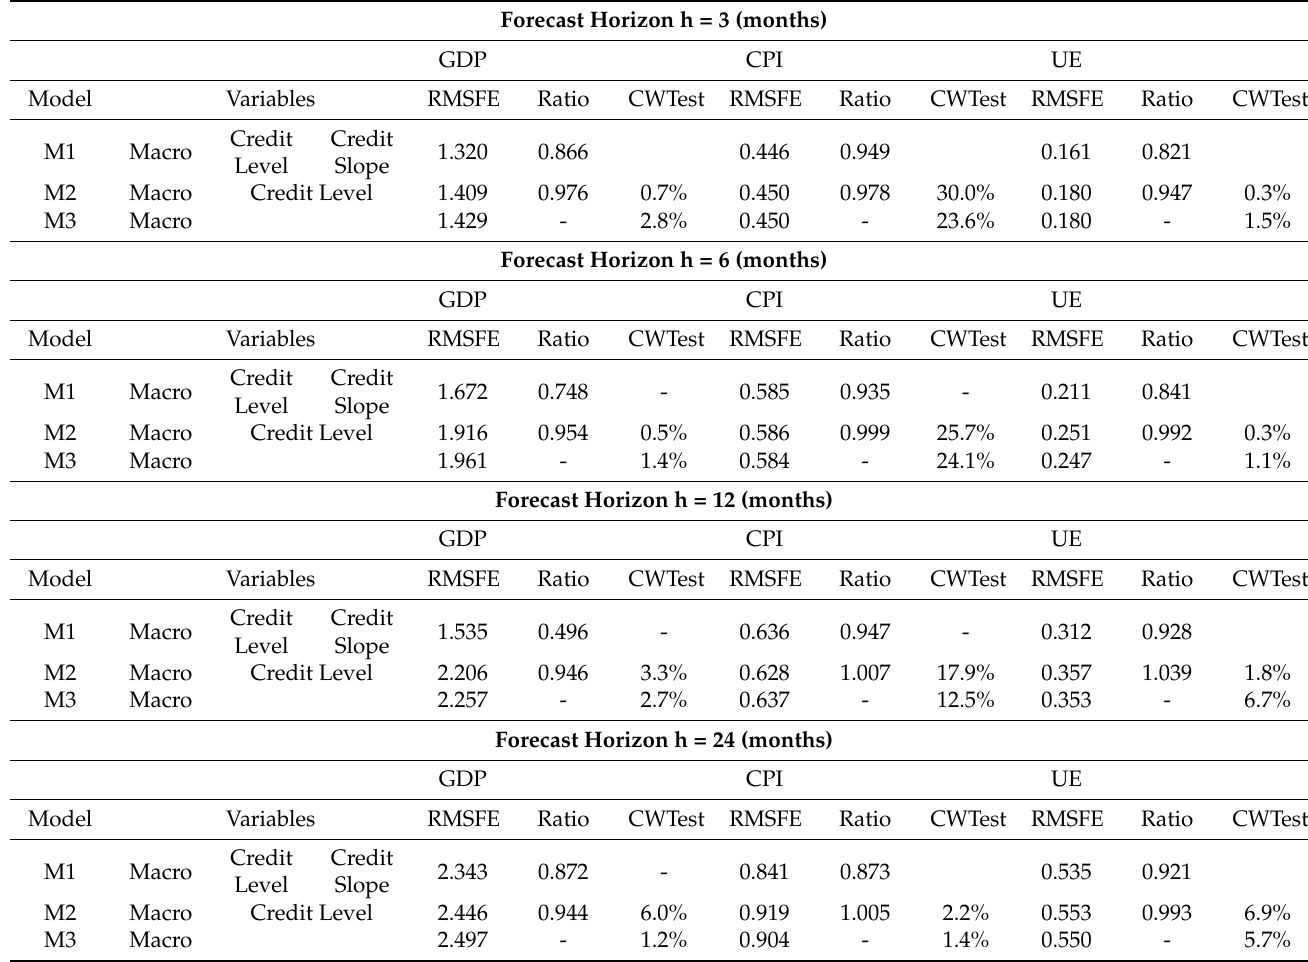
Table 3. Out-of-sample predictive content of credit spreads for economic